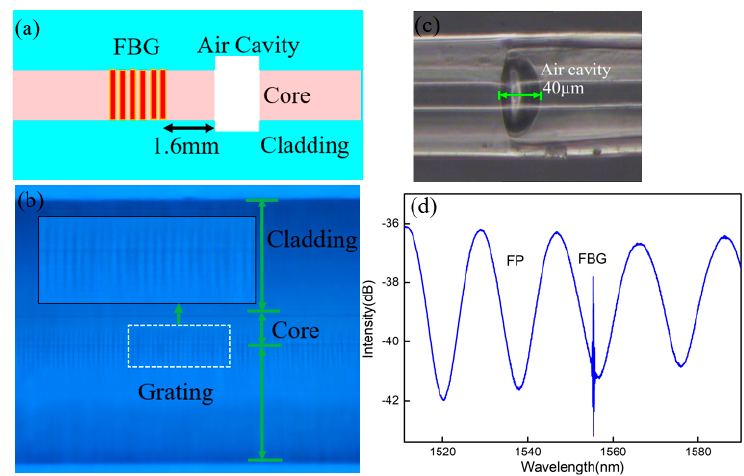
Figure 1. ( a ) Schematic diagram of the sensor head; ( b ) Micrograph of the FBG; ( c ) micrograph of the FP; ( d ) mixed spectrum of the FBG and the FP cavity.